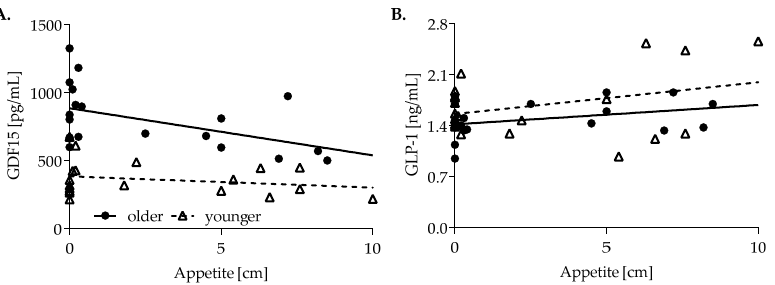
Figure 1. Correlation of baseline appetite and baseline ( A ) GDF15 (older: r = − 0.488, p = 0.029; younger: r = − 0.228, p = 0.347) and ( B ) GLP-1 concentrations (older: older, r = 0.461, p = 0.041; younger: r = 0.227, p = 0.350). GLP-1 was logarithmized for normalization. Correlations of GLP-1 were calculated using log-transformed values but are shown as untransformed values for better visualization. Closed circles represent older women, open triangles younger women.